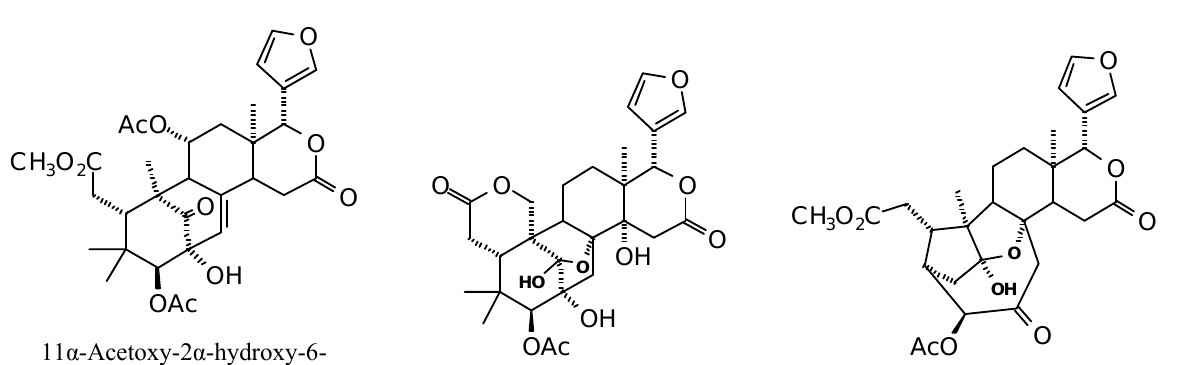
Figure 23. Limonoids examined in this